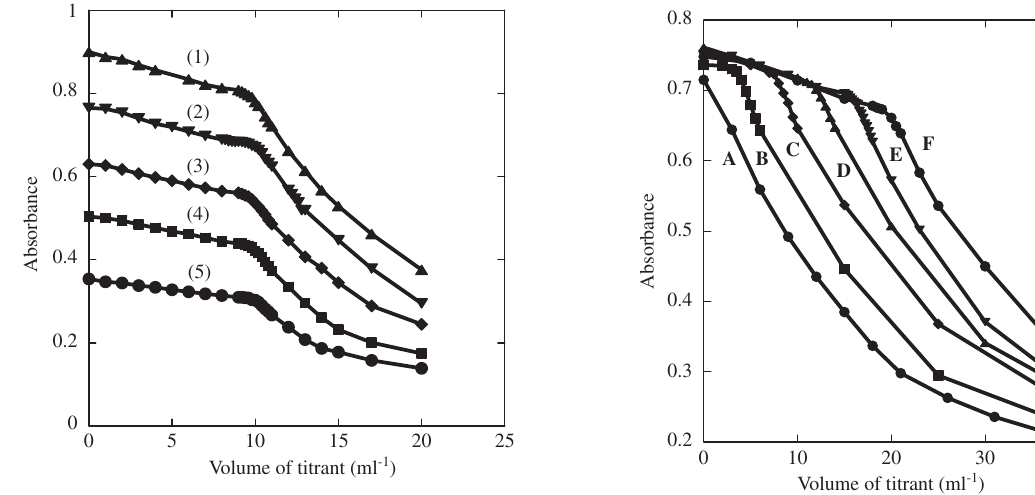
Figure 6 Photometric direct titration curves for PHMB-HCl (100.0 ml) containing 4.8 × 10 -3 m HCl and 1.0 × 10 -5 mol l -1 CV with a 1.0 × 10 -4 eq mol l -1 PVSK standard solution. Sample solution: (A) 0, (B) 2.0 × 10 -6 , (C) 4.0 × 10 -6 , (D) 6.0 × 10 -6 , (E) 8.0 × 10 -6 , (F) 1.0 × 10 -5